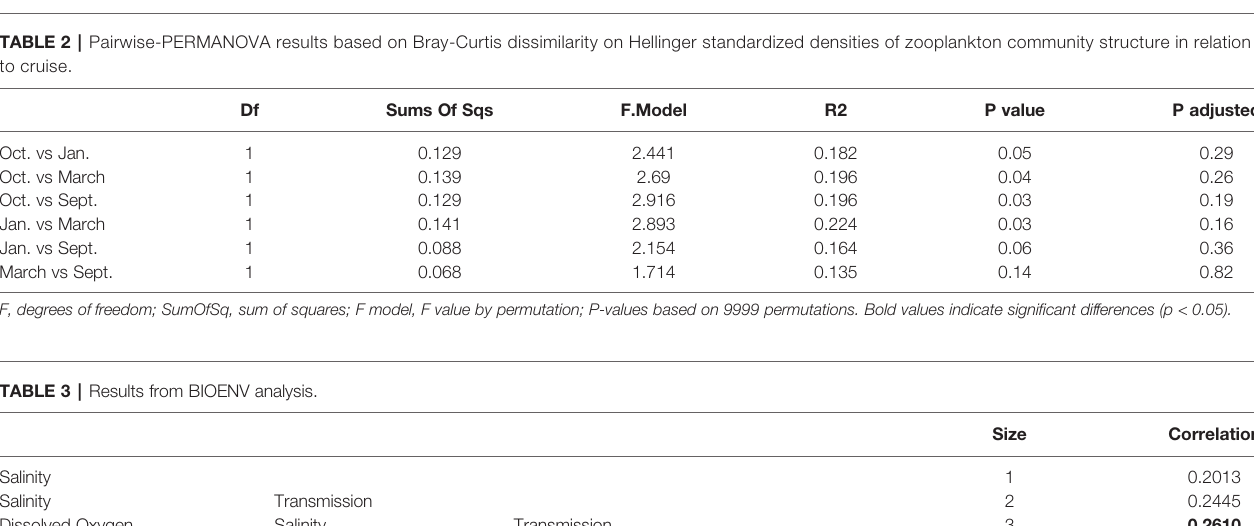
Bold font indicates signi fi cant (p < 0.05) results.